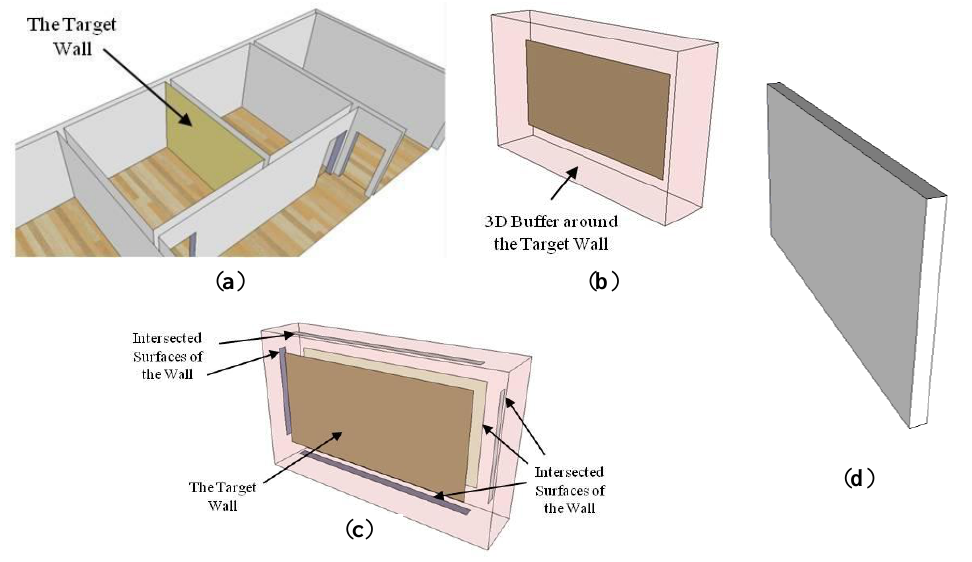
Figure 10. ( a ) Perspective view of the target wall. ( b ) The target wall surrounded by a 3D Buffer. ( c ) The target wall composed of its 6 surfaces. ( d ) The target wall constructed as a building